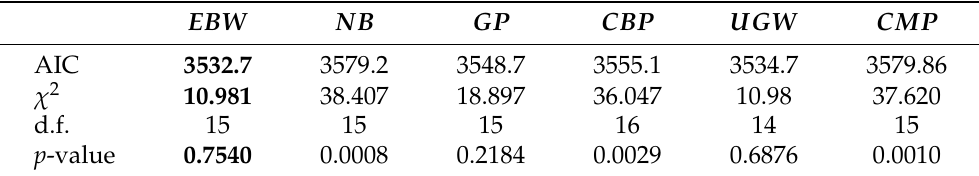
Table 5. AIC values and χ 2 -goodness of fit test for data about some sports